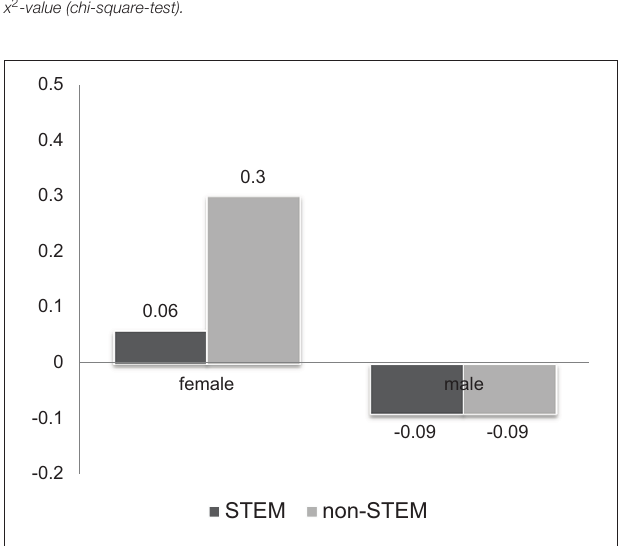
differs significantly, whereas the attribution of masculinity to chemistry and physics does not [[ − 0.20, 0.02], [ − 0.07, 0.09]].